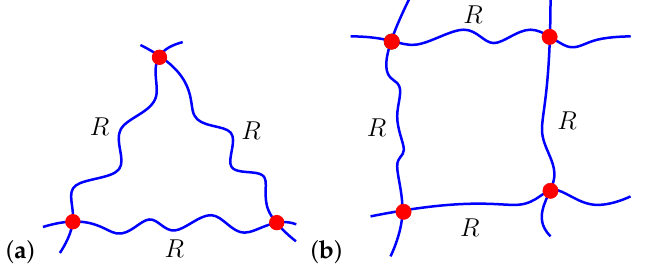
Figure 2. Schematics of ( a ) locally triangular ( m = 3) and ( b ) locally quadrilateral ( m = 4) chain